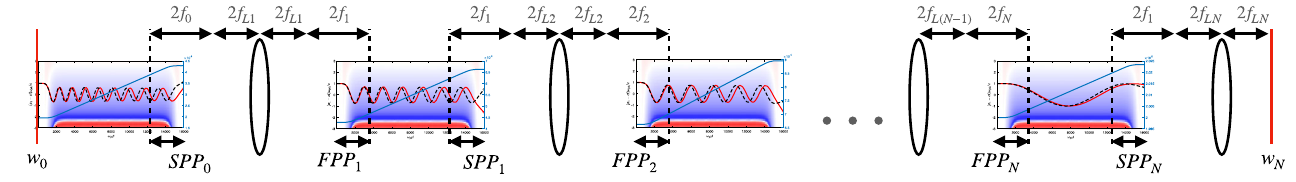
FIG. 1. Schematic showing N stage plasma accelerator, with (chromatic) focusing lenses between plasma accelerating stages with 2 f focusing throughout. f is the plasma stage focal length and f is the beam focusing optic focal length (at the design energy) of the s th s Ls accelerating stage. FPP and SPP are the primary and secondary principal planes of the accelerating stage, s s